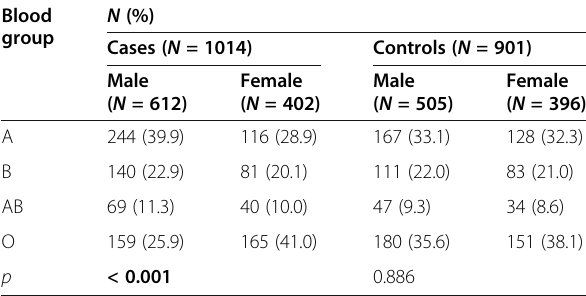
Table 4 ABO blood groups in COVID-19 cases and controls distributed according to gender Blood group